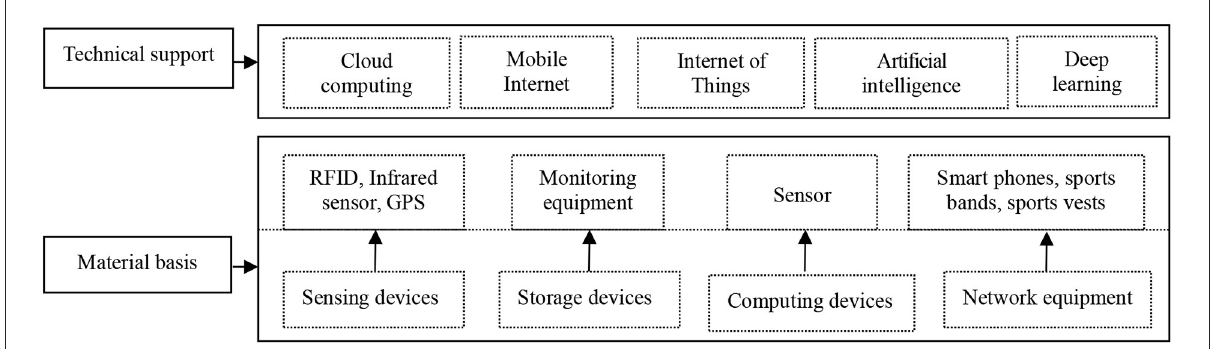
FIGURE2 Infrastructure architecture.